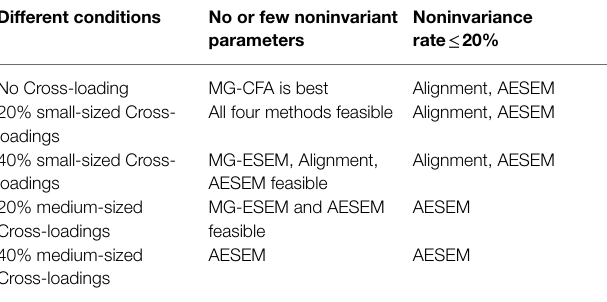
TABLE 8 | Applicability of multiple-group CFA, multiple-group ESEM, alignment and aligned ESEM. Different